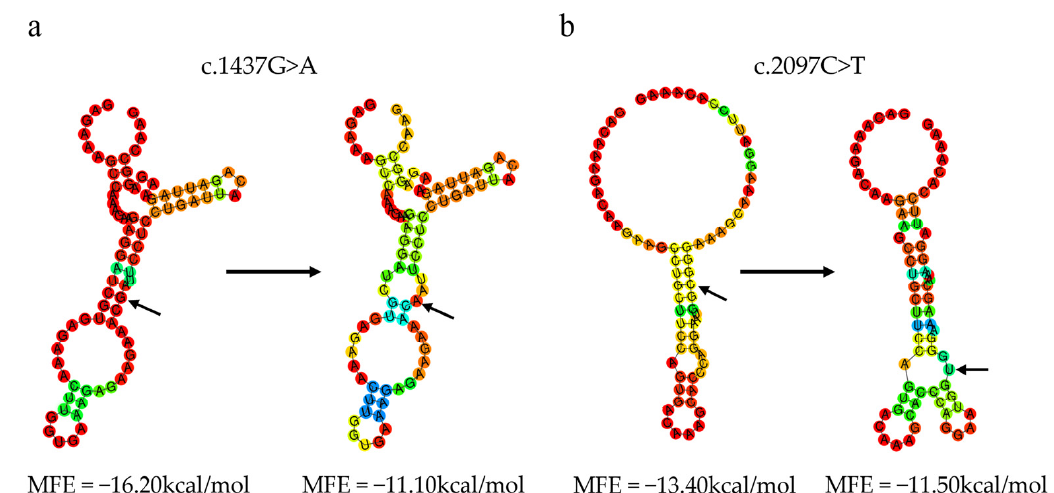
Figure 8. The minimum free energy (MFE) of secondary structure in exons 19 and 26 of the CAST gene. MFE prediction in terms of the secondary structure and free energy. ( a ) The secondary structure for the wild-type mRNA sequence of exon 19 with the G allele at the c.1437G>A site and the secondary structure for the mRNA sequence of exon 19 with the A allele at the c.1437G>A site. ( b ) The secondary structure for the wild-type mRNA sequence of exon 26 with the C allele at the c.2097C>T site and the secondary structure for the mRNA sequence of exon 26 with the T allele at the c.2097C>T site. The structure above is colored according to base-pairing probabilities.